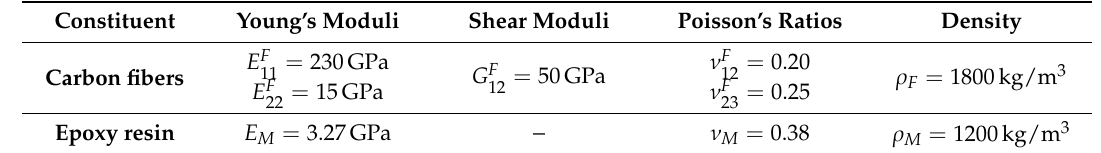
Table 2. Mechanical properties of the layer constituents.